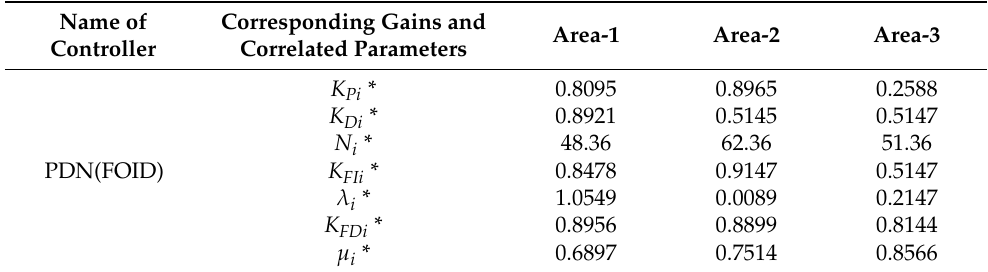
Figure 12. Evaluation of system-6 outcomes employing SHO-optimized PDN(FOID) controller after exposure to random load disturbance contrast time: ( a ) Anomaly of frequency in area-1, ( b ) Anomaly of frequency in area-3, ( c ) Anomaly of Tie-line power interlinking area-1 and area-2, ( d ) Anomaly of Tie-line power interlinking area-1 and area-3. Table 10. Finest values of gains and correlated parameters of PDN(FOID) controllers for scheme-6 when conditional to a random pattern of disturbance.